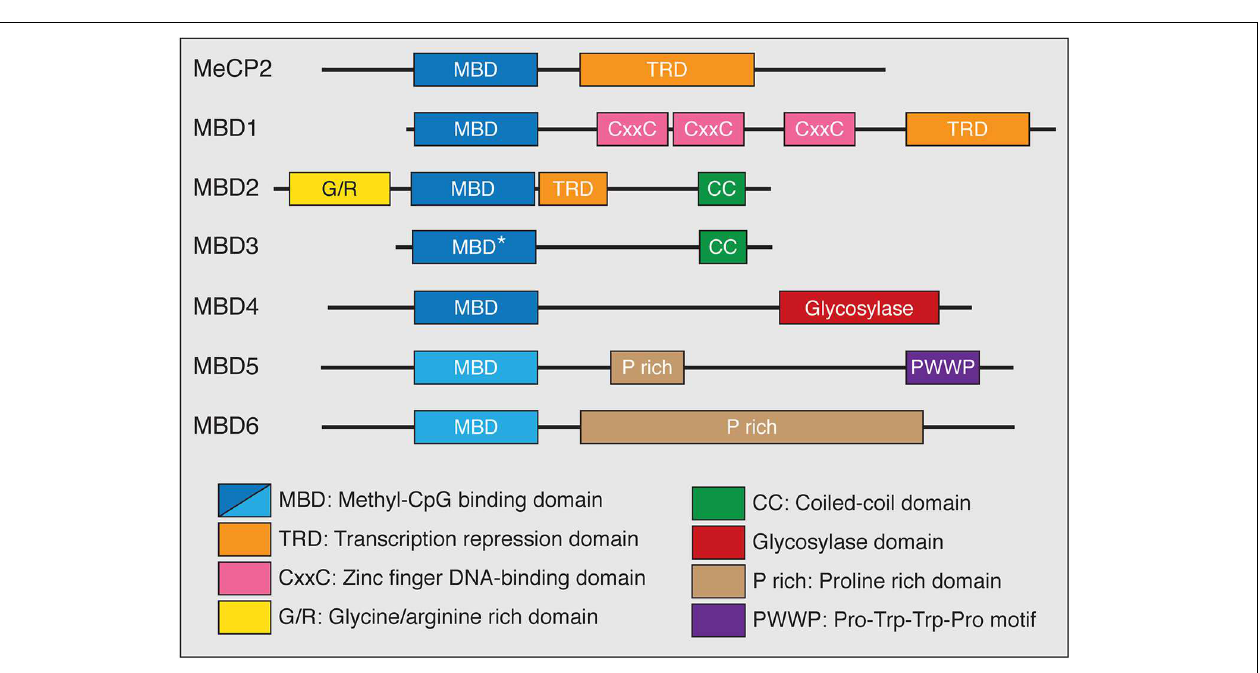
Figure 3A ; Hendrich and Bird, 1998; Hendrich et al.,